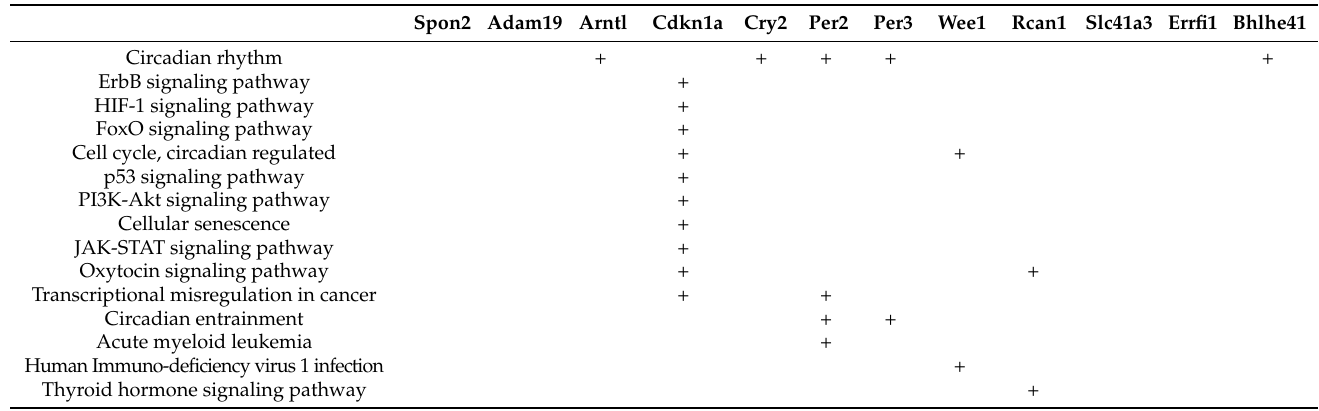
Table 5. Intracellular pathways involvement of 12 overlapping differentially expressed